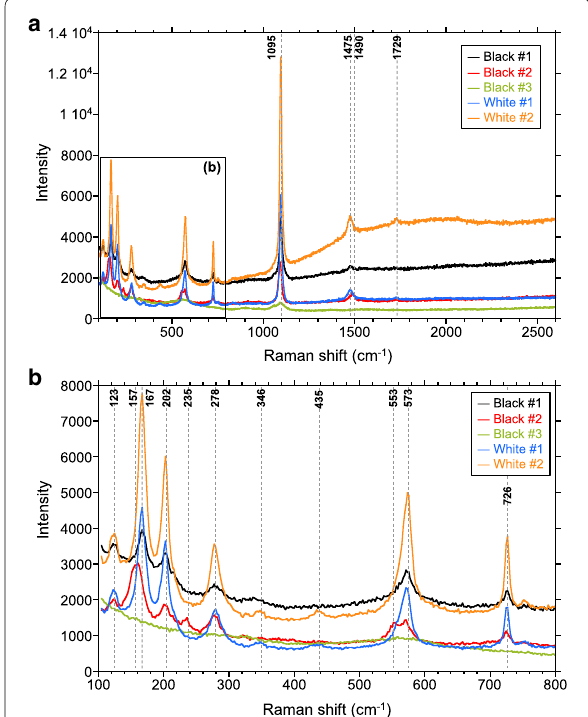
Fig. 11 Raman spectra of the carbonaceous sample from the quenched product. “Black” indicates the spectra obtained from the black materials, and “white” indicates the spectra obtained from the white